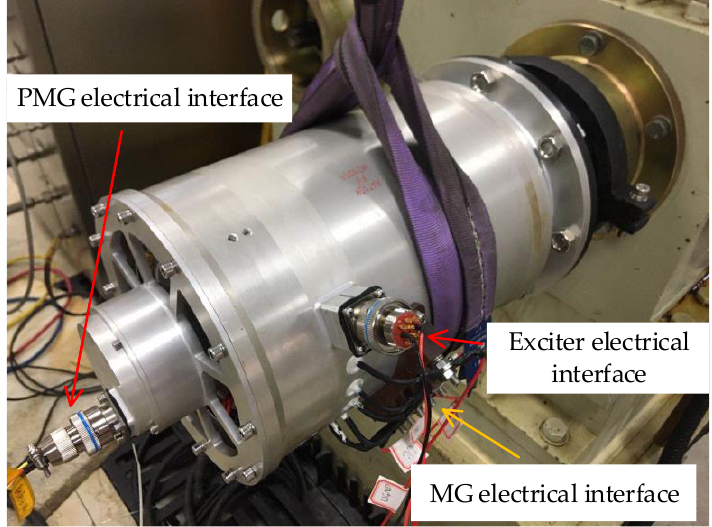
Figure 16. Prototype generator.